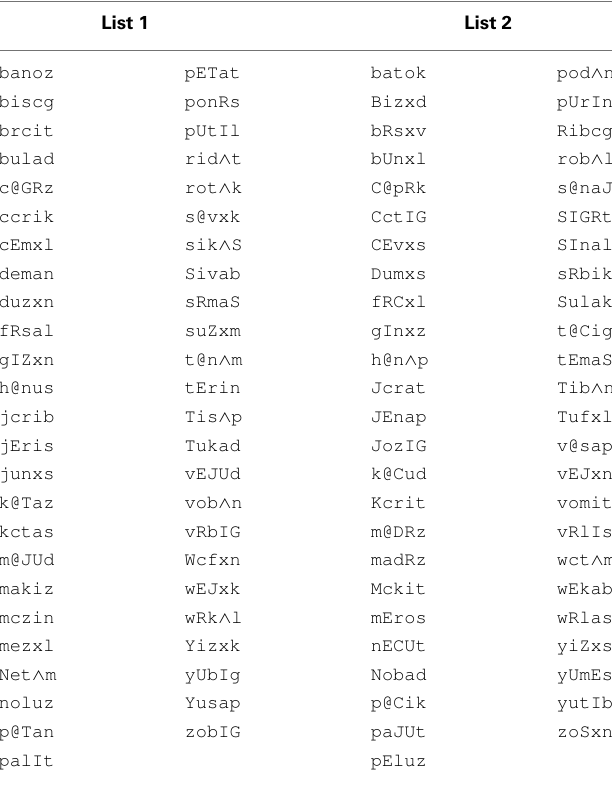
Table 2 |Transcription keys for nonsense word consonants and vowels. Consonant sounds represented by lower case on